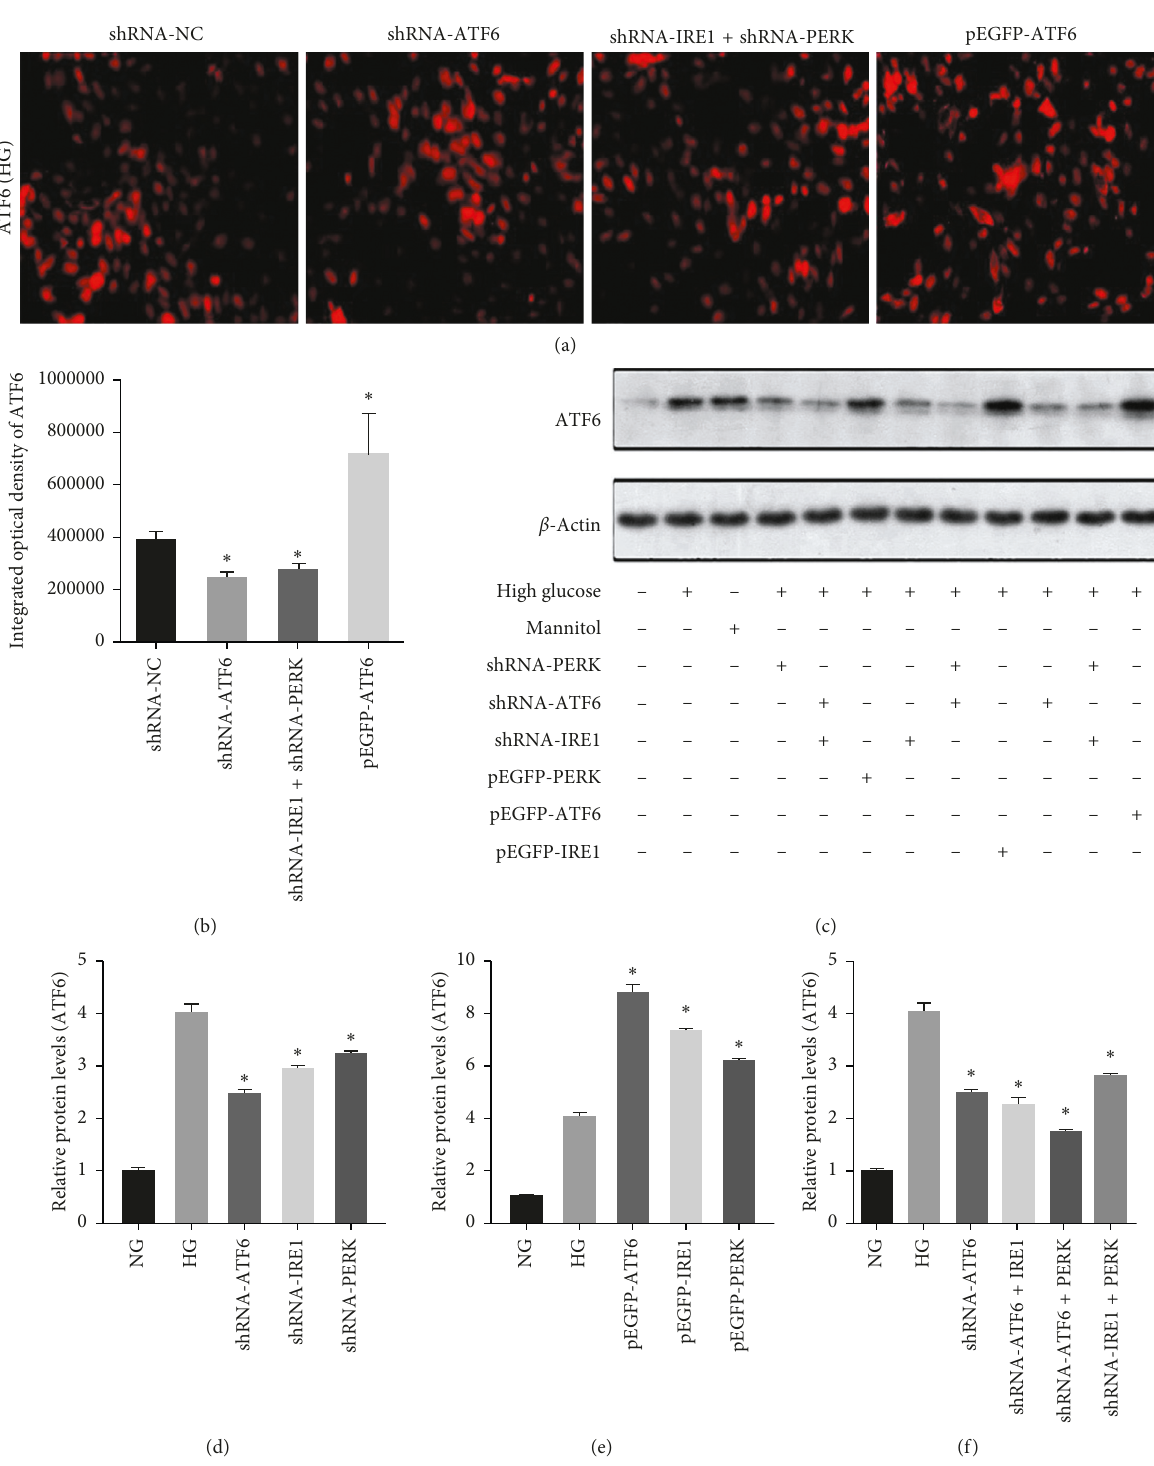
Figure 6: Immunofluorescence and immunoblotting of ATF6 in rMCs at HG. (a, b) Suppression of UPR pathways significantly decreased ATF6 immunofluorescence. (c–f) The protein levels of ATF6 in rMCs transfected with PERK, ATF6, and IRE1 shRNAs or overexpression plasmids at HG for 48hours were measured by western blot analysis. The results were representative of 3 independent experiments ( n � 3; ∗ p < 0 .